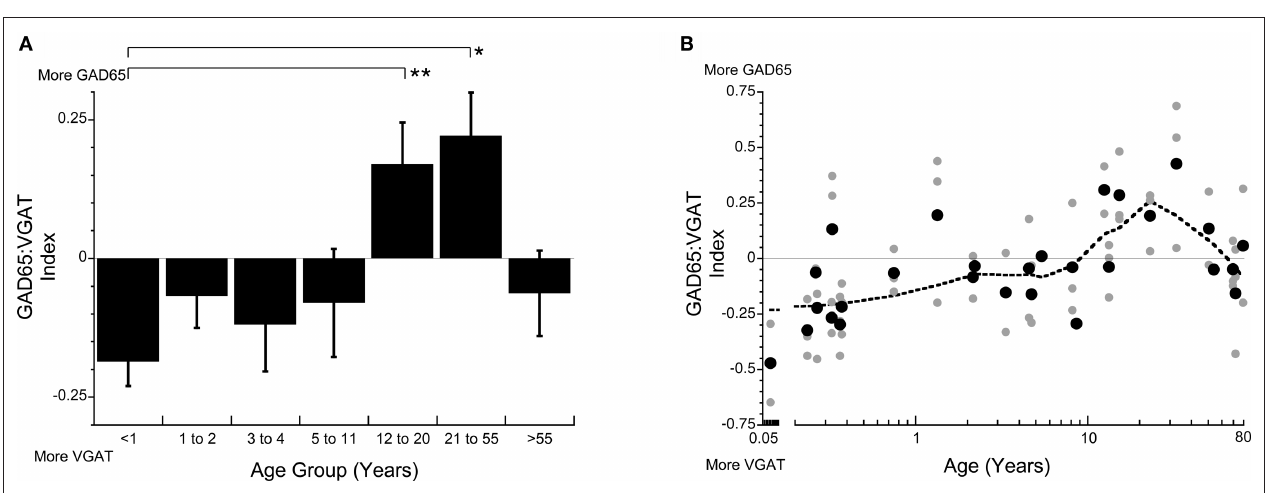
p < 0.0002) (A,B) . The lines above the histograms identify the groups that were significantly different (Tukey’s post hoc HSD, * p < 0.05, ** p < 0.02, *** p < 0.001) (• average expression for each case; • all runs; dotted line is the weighted average).